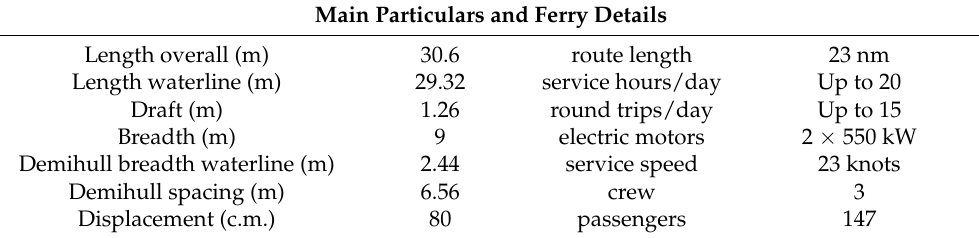
Table 2. Case ship